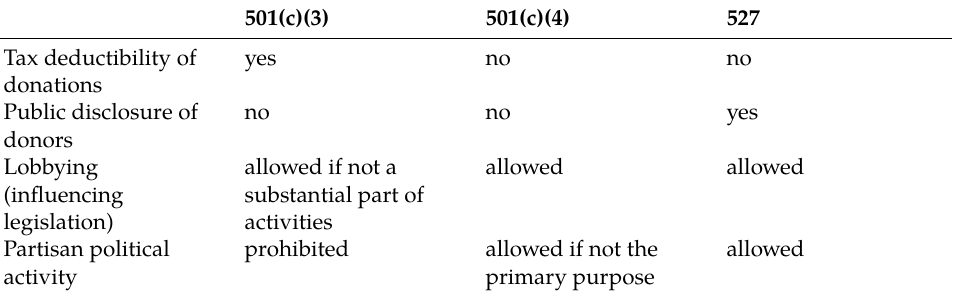
Table 1: U.S. organizational type and activities